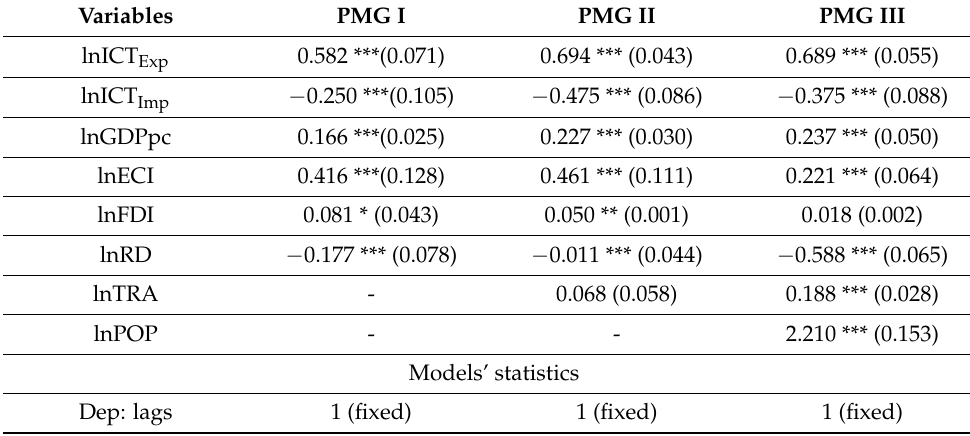
Table 7. Estimations under PMG-ADRL